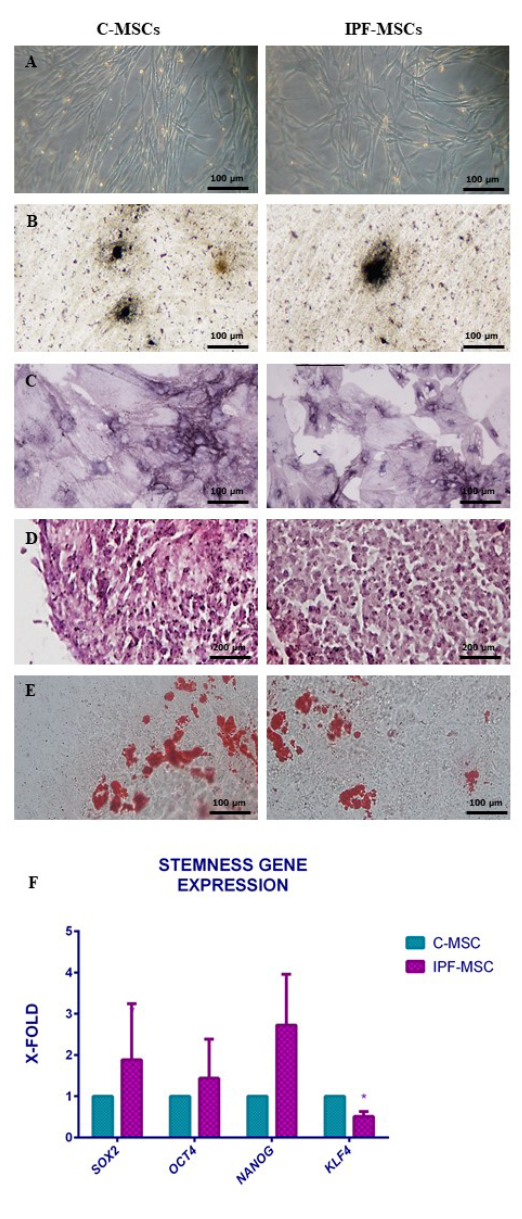
Figure 1. Mesenchymal stem cells (MSCs) characterization. Phase-contrast images ( A ) of MSCs derived from control lung tissue (C-MSCs) and from lung of patients a ff ected by idiopathic pulmonary fibrosis (IPF) (IPF-MSCs) after 14 days of culture (scale bar, 100 µ m); representative images of osteogenic di ff erentiation assessment by von Kossa staining ( B , scale bar 100 µ m) and alkaline phosphatase (ALP) reaction ( C, scale bar 100 µ m); chondrogenic di ff erentiation by safranin-O coloration ( D , scale bar 200 µ m); adipocyte di ff erentiation by oil red staining ( E , scale bar 30 µ m). The histogram ( F ) depicts the expression of genes related to stemness. Levels of expression detected in IPF-MSCs are referred as X-fold with respect to C-MSCs (expressed equal to 1). Data are means ± SD from analyses performed on three separate experiments in triplicates. The * indicates significative di ff erences between C-MSCs and IPF-MSC (unpaired t -test; p <